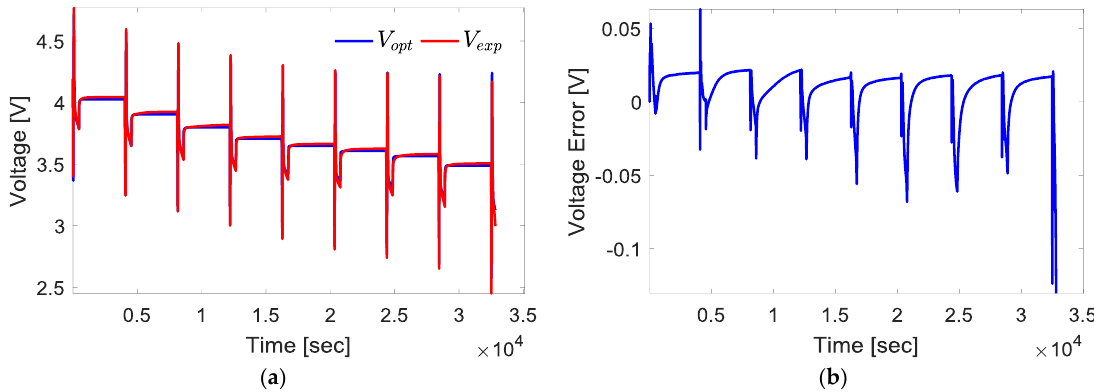
Figure 7. The identification results under HPPC condition at 30 °C: ( a ) terminal voltage of the optimal and the experimental model; and ( b ) voltage error.